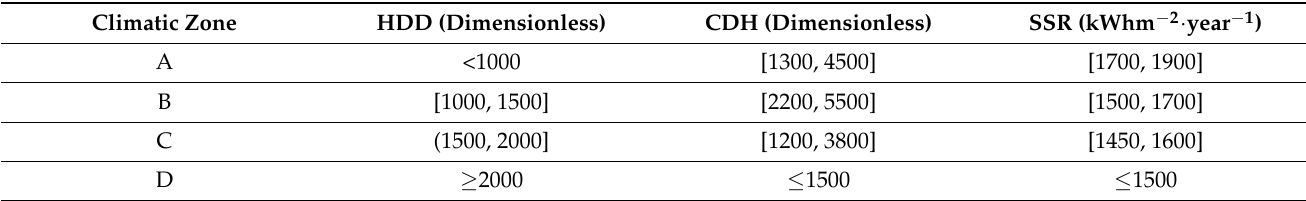
Table 2. Range of annual heating degrees days (HDD), cooling degree hours (CDH), and surface solar radiation (SSR) values to define the climatic zones in Greece for energy-saving in buildings [58]. The calculation of HDD and CDH considers the following cold and warm periods of the year: (1) climatic zones A and B, November 1–April 15 and May 15–September 15, respectively, and (2) climatic zones C and D, October 15–April 30 and June 1–August 31, respectively. Climatic